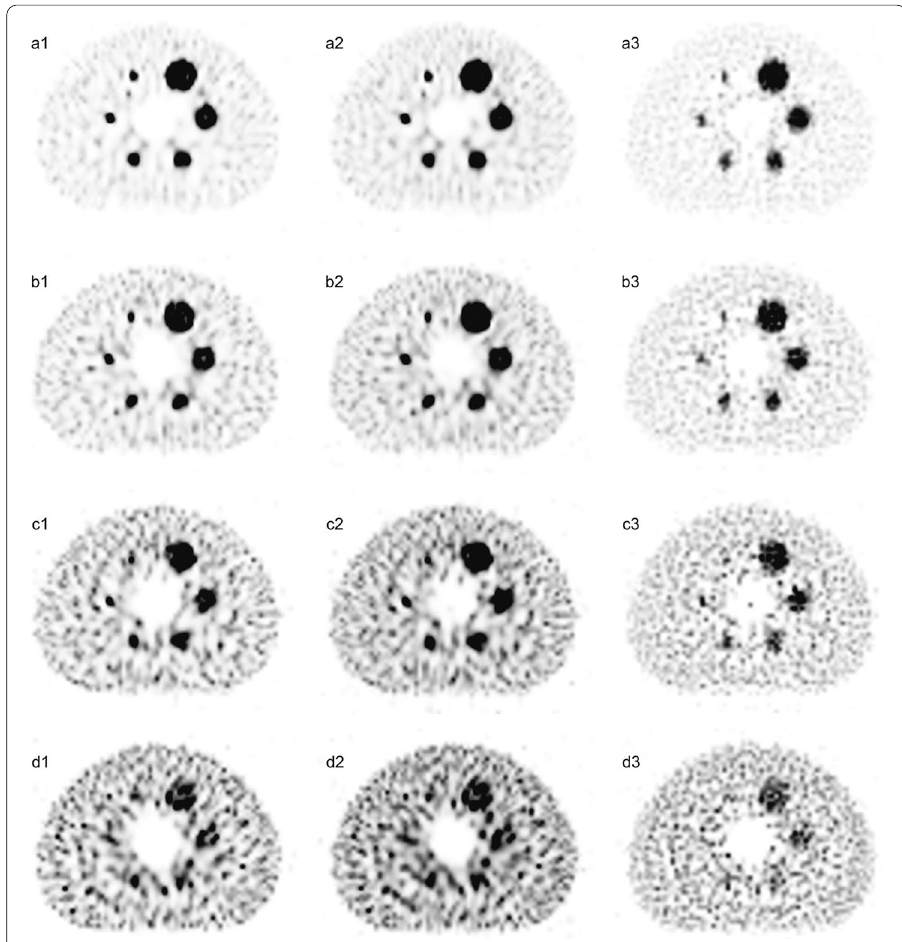
Fig. 6 Images reconstructed with different image correction combinations. Rows were the images of different T/B ratios (32:1, 16:1, 8:1, and 4:1, respectively, from the top to the bottom; a 32:1; b 16:1; c 8:1; d 4:1); Columns are the images reconstructed with different correction combinations (1, AC 3, AC SC). Fixed reconstruction parameters: 35 iterations, 20 subsets, no filter; Fixed acquisition parameters: + 120 s/frame of acquisition time, 15% energy